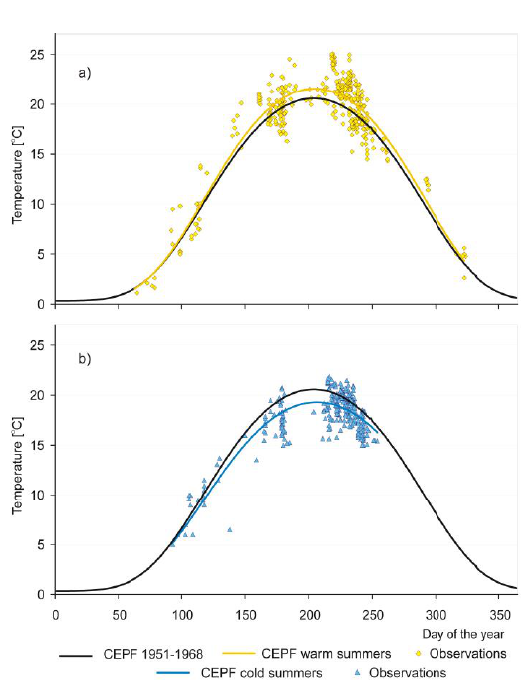
Figure 8. The in situ measurements of the water temperature (average in the layer 0 – 3 m) in Polish lakes ( a ) in the years with a warm summer (with the warmest in 1959 and 1963) and ( b ) in the years with a cold summer (with the coldest in 1962 and 1965) in the 1951 – 1968 period, with linear interpolation to calculate the daily temperature. CEFP 1951 – 1968 — complementary error peak function for the 1951 – 1968 period — Equation (1); CEFP warm summer — complementary error peak function for the years with the warm summer in the 1951 – 1968 period — Equation (2); CFPF cold summer — complementary error peak function for the years with the cold summer in the 1951 – 1968 period — Equation (3).